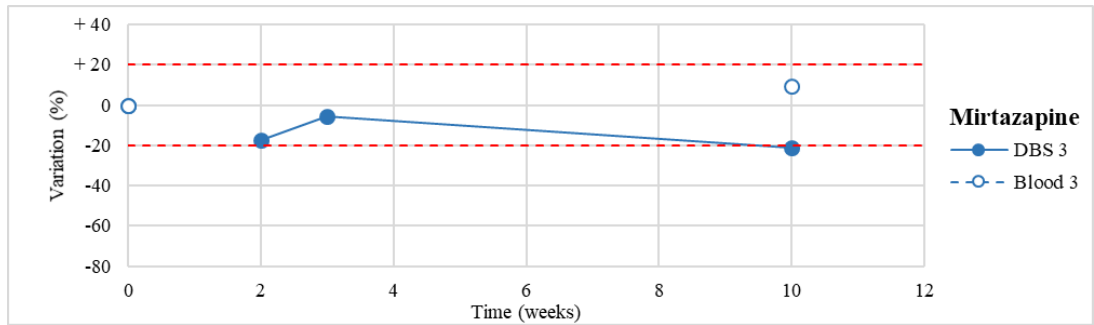
Figure 3. Long-term stability of citalopram ( n = 2) in dried blood spots (DBSs) stored at room temperature and in blood stored at −20 °C (T0–T4).